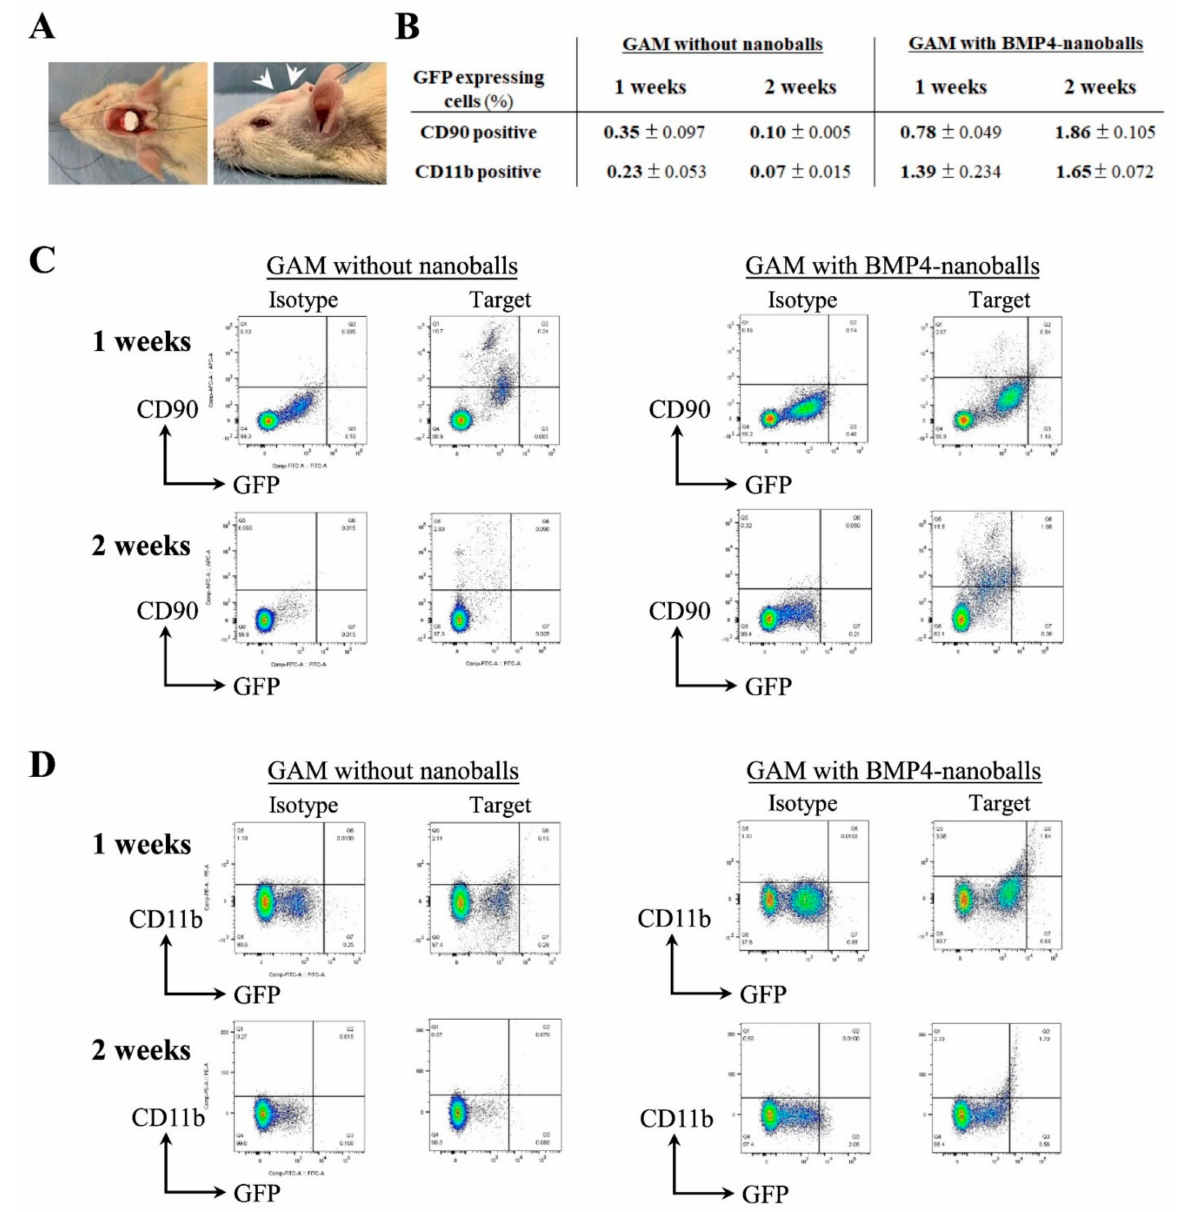
Figure 5. Detection of the biological activity of GAM with nanoballs (5 µ g) in vivo. ( A ) Photographs of GAM transplantation onto the rat cranium bone as a bone augmentation model. White arrows indicate the GAM portion post-transplantation. ( B ) The percentages of CD90- (as an MSC marker) or CD11b (as a macrophage marker)-positive cells in GFP-expressing transfected cells isolated from GAM specimens at 1- or 2-weeks post-transplantation. The data represent the mean ± SD ( n = 5). ( C ) Density plots from flow cytometry for CD90- and GFP-positive subpopulations in GAM with/without BMP4- nanoballs at 1- or 2-weeks post-transplantation. ( D ) Density plots from flow cytometry for CD11b- and GFP-positive subpopulations in GAMs with/without BMP4-nanoballs at 1- or 2-weeks